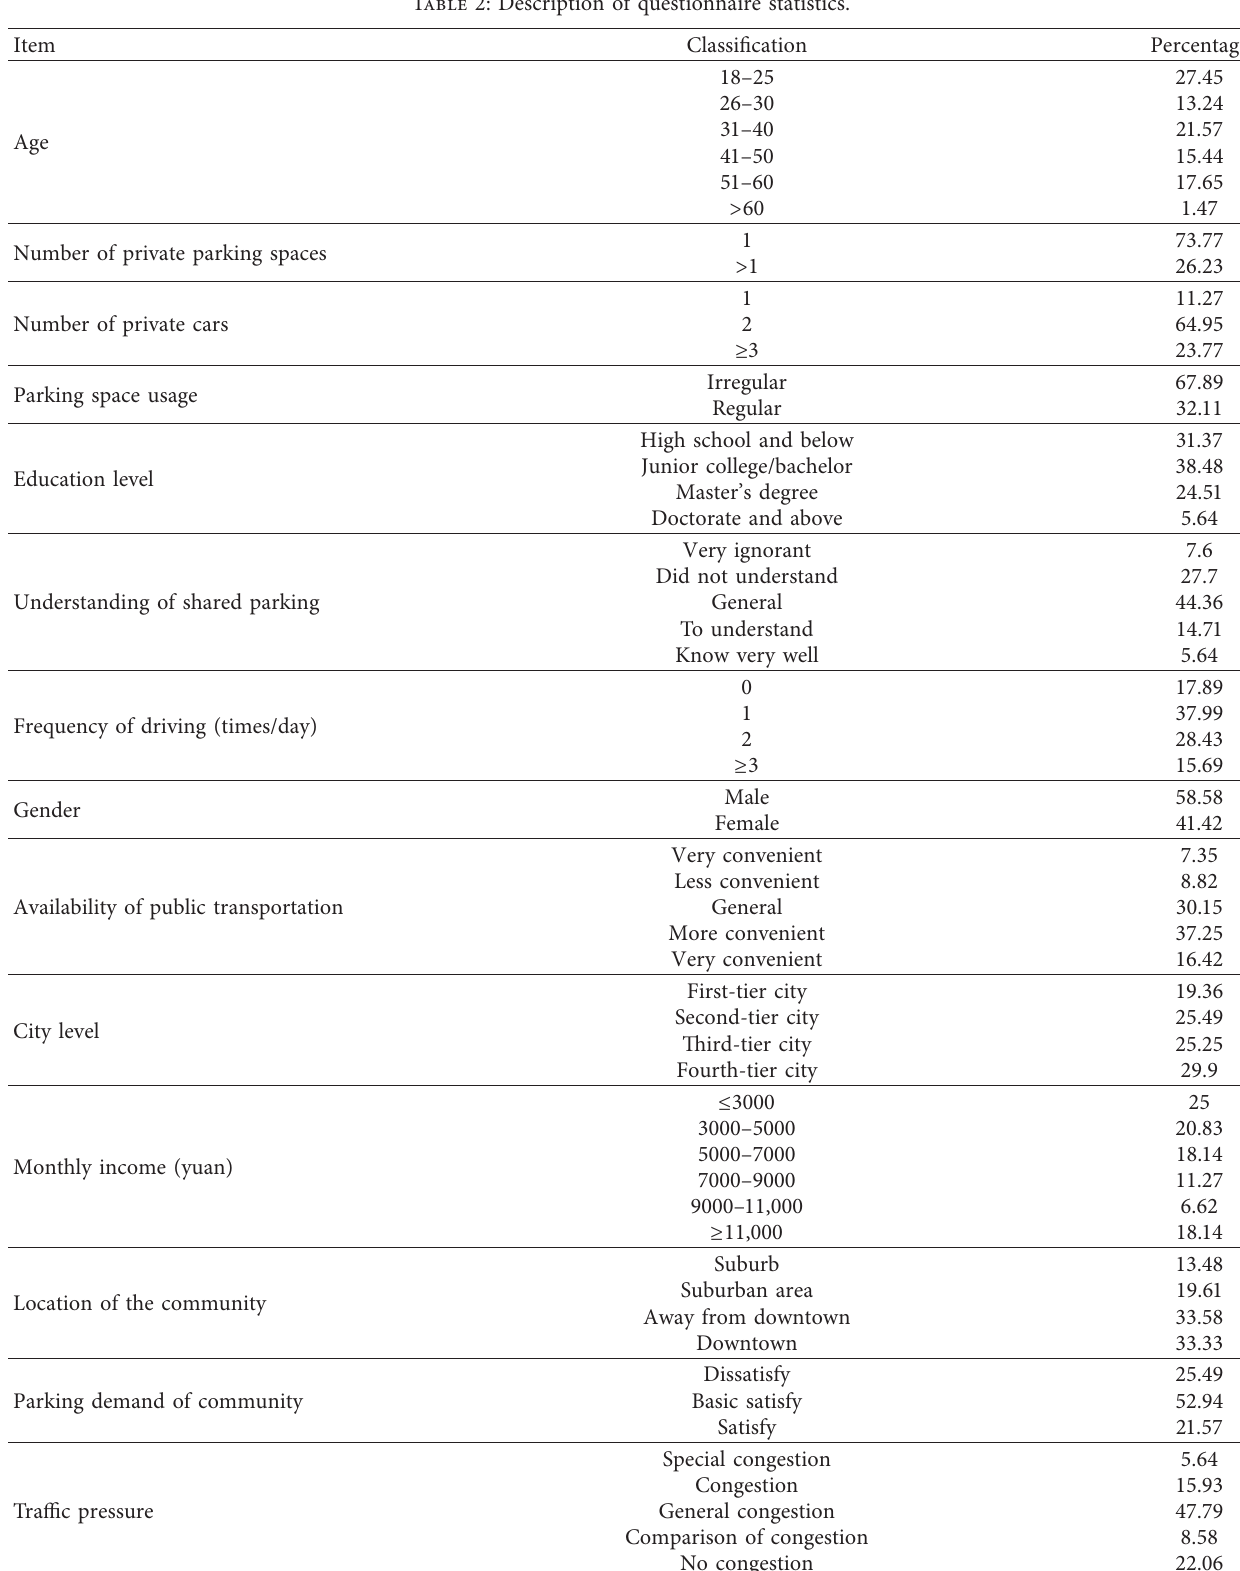
Table 2: Description of questionnaire